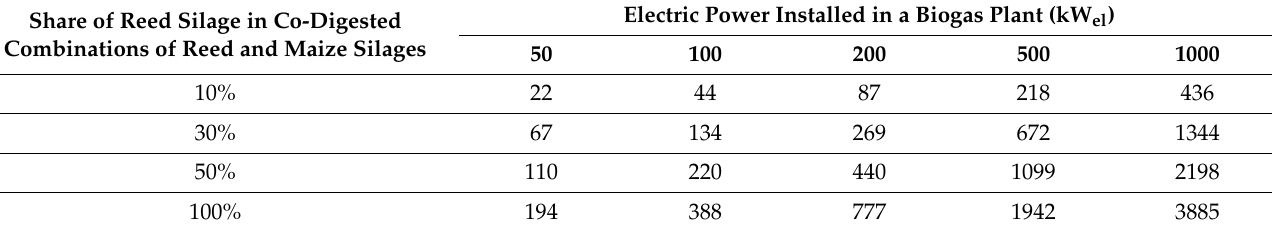
Table 11. The number of households supplied with heat from the incineration of reed biomass harvested from the area which should be harvested to supply biogas plants of various electric power installed and operating on different combinations of maize and reed silages. Electric Power Installed in a Biogas Plant (kW el Share of Reed Silage in Co-Digested Combinations of Reed and Maize Silages